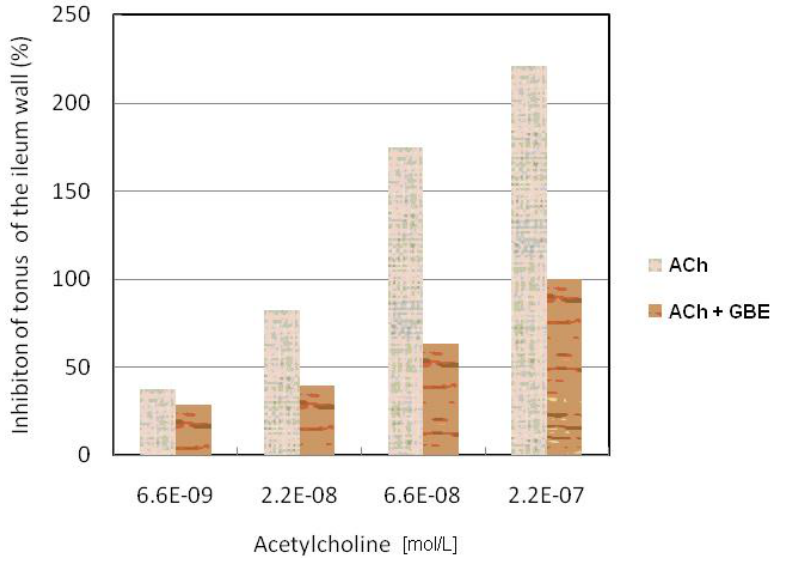
Figure 2. Inhibitory effect of GBE on the increase of tonus of the ileum wall provoked by